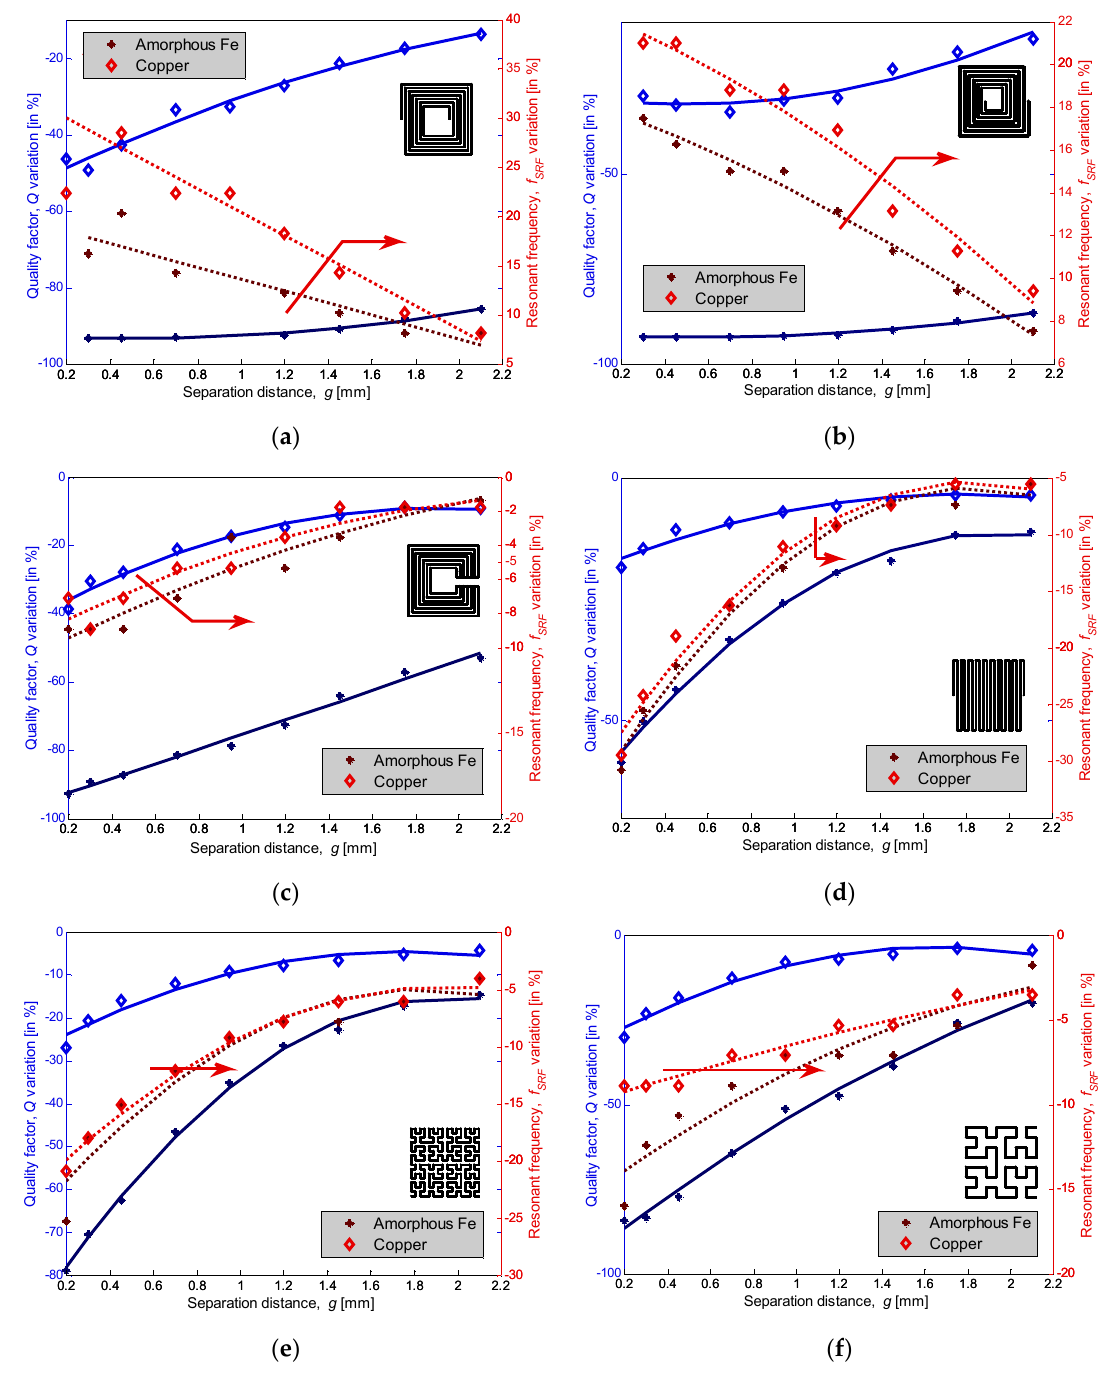
Figure 8. Variation range sensitivity percentage (quality factor in solid lines plotted on the left y -axis and resonant frequency in dashed lines plotted on the right one) versus different distances at 1 MHz: ( a ) spiral, ( b ) tapered spiral, ( c ) non-spiral, ( d ) meander, ( e ) fourth-order fractal, and ( f ) third-order fractal.